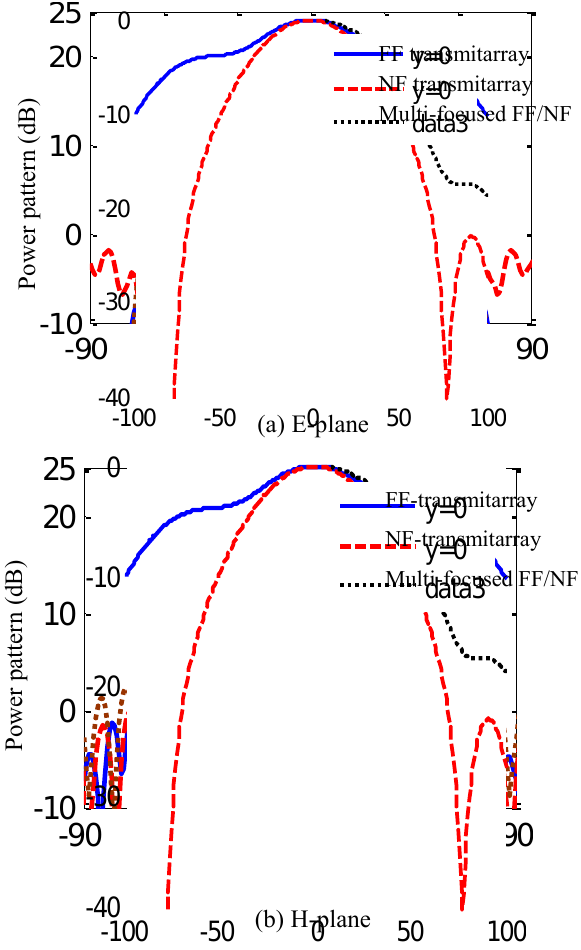
Figure 10: The E-plane and H-plane radiation patterns variations versus the elevation angle for FF-focused transmitarray, NF-focused transmitarray, and dual-focused transmitarray, at F/D = 0.9, R o = 310 mm, and frequency 10 GHz.